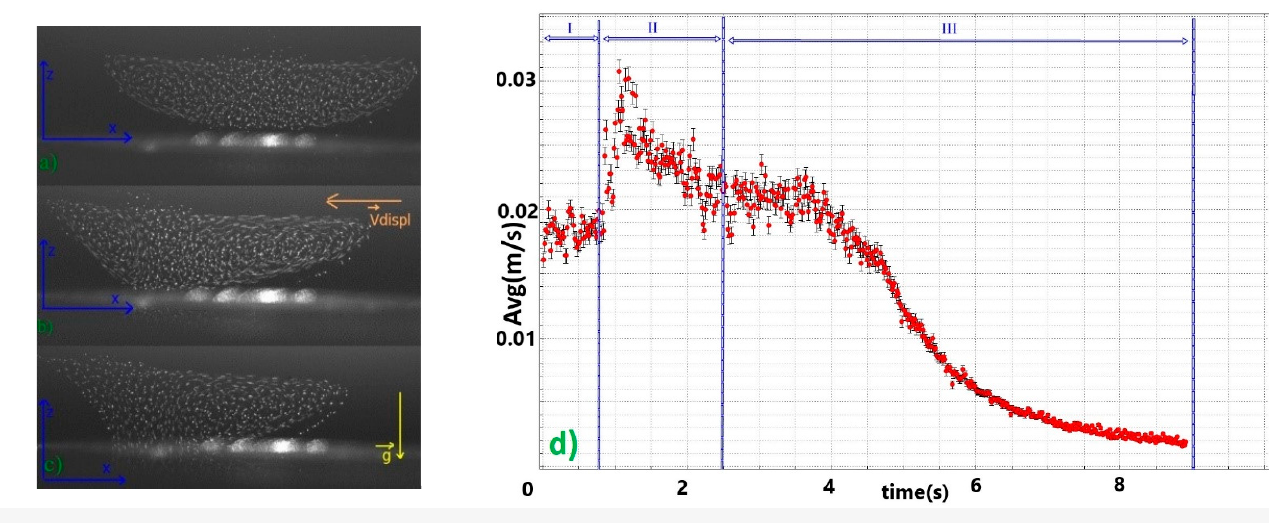
Figure 5. ( a ) Initial plasma crystal with symmetrical vortexes; ( b ) stretched and compressed vortexes after 0.78 s from the gas pressure rising and displacement on the x axis, from +x to − x; ( c ) the falling particles after 4 s; and ( d ) average speed of rotational dusty plasma associated with the three phases of the crystal.